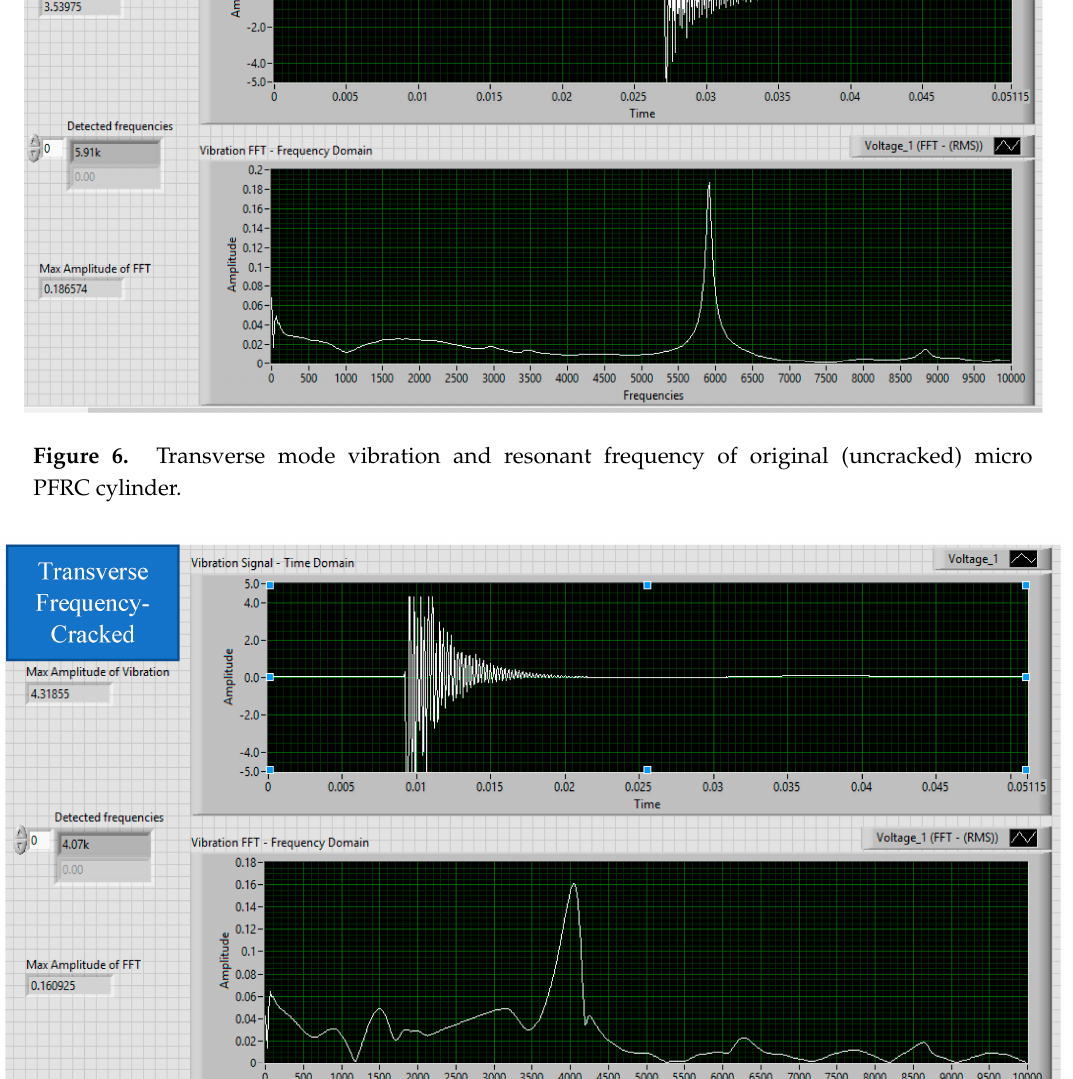
Figure 7. Transverse mode vibration and resonant frequency of cracked micro PFRC cylinder.